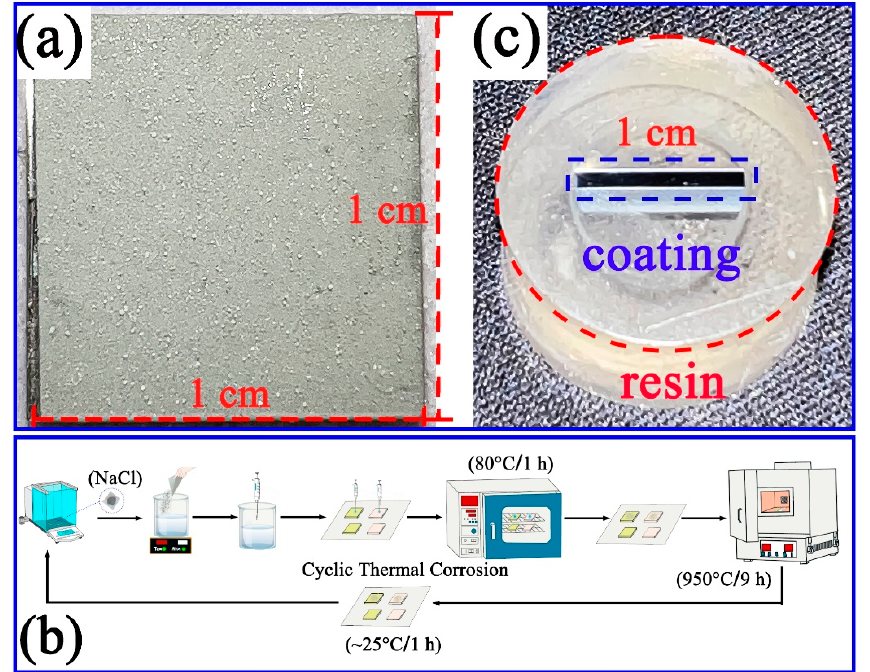
Figure 1. ( a ) Original visual images of the YSZ coating; ( b ) flow chart of high-temperature corrosion and ( c ) mosaic model. Table 1. Preparation parameters of YSZ.